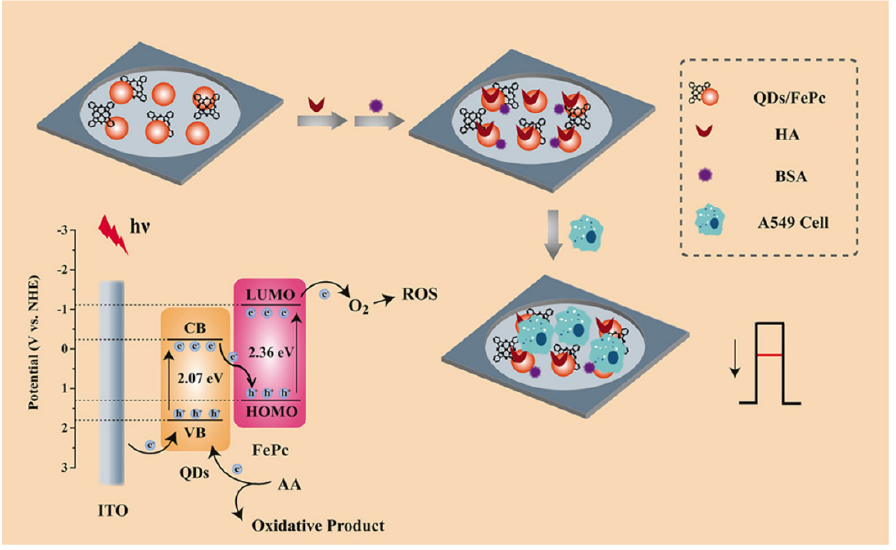
Figure 4. Schematic diagram of the sensing platform proposed by Wang. Reproduced with